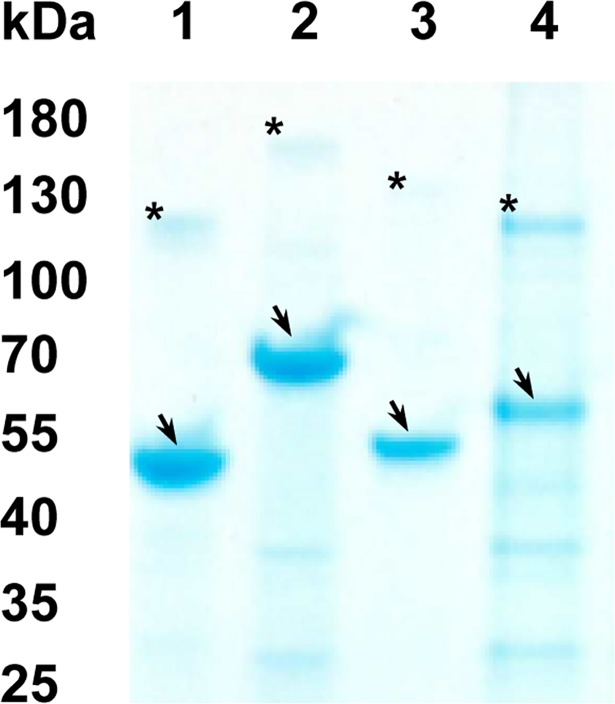
SDS-PAGE of purified recombinants.Lane 1: SERA3 ag1; Lane 2: SERA3 ag2; Lane 3: SSP2/TRAP and Lane 4: TSERA2 ag1. Band sizes are indicated on one side in kDa (Fermentas PageRuler Prestained Protein Ladder). Samples were ran under reducing conditions at approximately 0.4 mg/ml per lane on a 4–20% gradient gel (NuPAGE, BioRad) and stained with Coomassie Blue (BioSafe, BioRad). The arrows and asterisks indicate the protein monomers and aggregates, respectively.